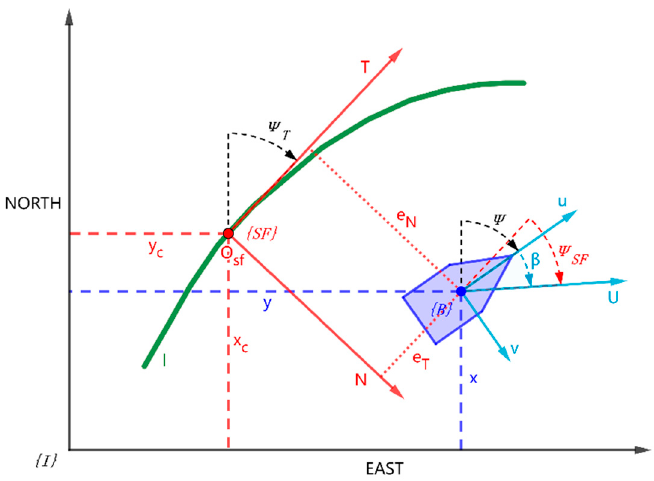
Figure 2. USV path following in Serret-Frenet coordinate frame.